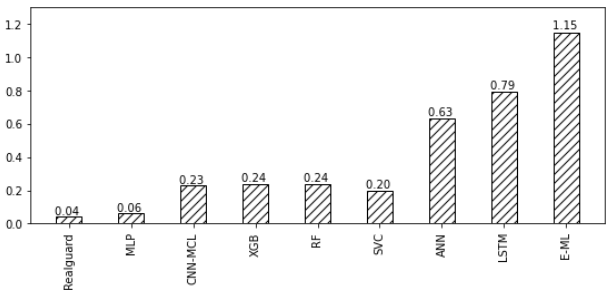
Figure 5. Comparing the TPR value of the multi-class attack detection between Realguard and its competitors.